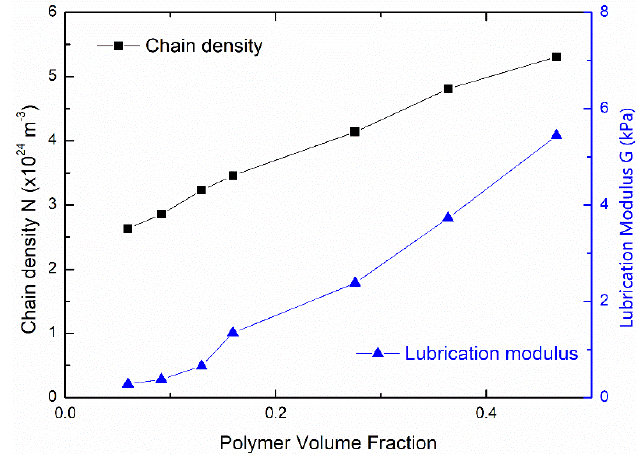
Figure 8. Two fitting parameters vs. the polymer volume fraction (Black dots are chain density N; Blue dots are lubrication modulus G.).